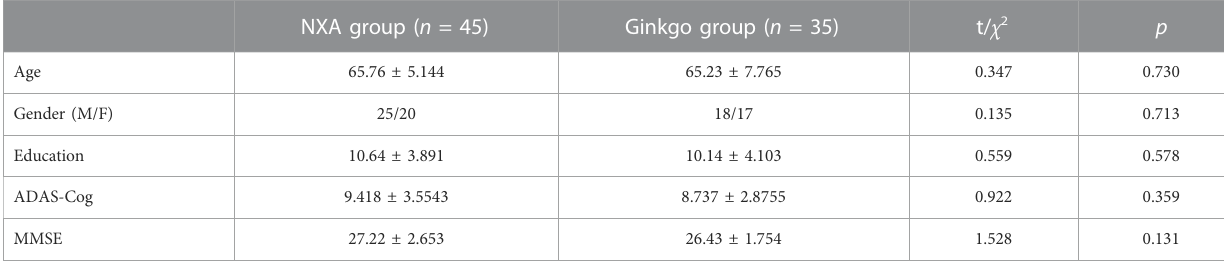
TABLE 1 Baseline characteristics of